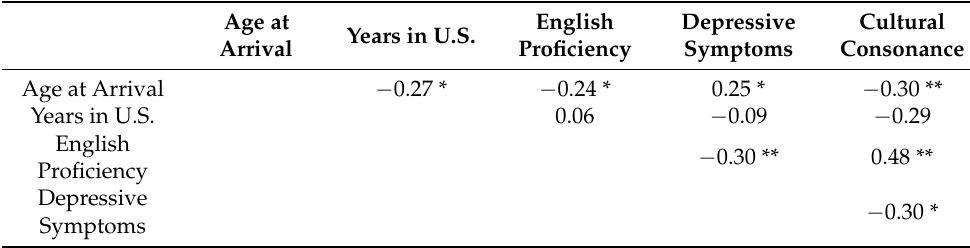
Table 4. Bivariate correlation matrix between acculturation measures, cultural consonance, and depressive symptoms. Age at English Depressive Cultural Years in U.S. Arrival Proficiency Symptoms Consonance Age at Arrival − 0.27 * − 0.24 * 0.25 * − 0.30 ** Years in U.S. 0.06 − 0.09 −